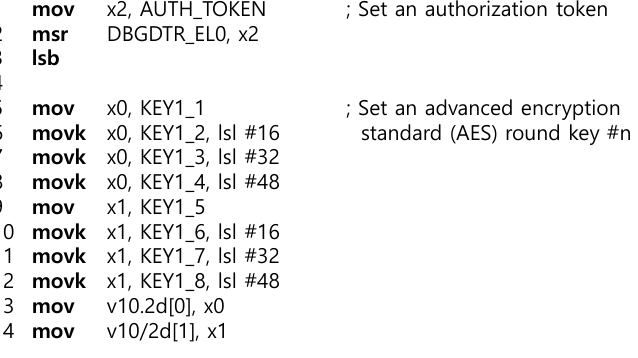
Figure 4. Entry gate of Sealer. Setting an AES round key (from Line 5 to Line 14) is repeated for all 11 AES round